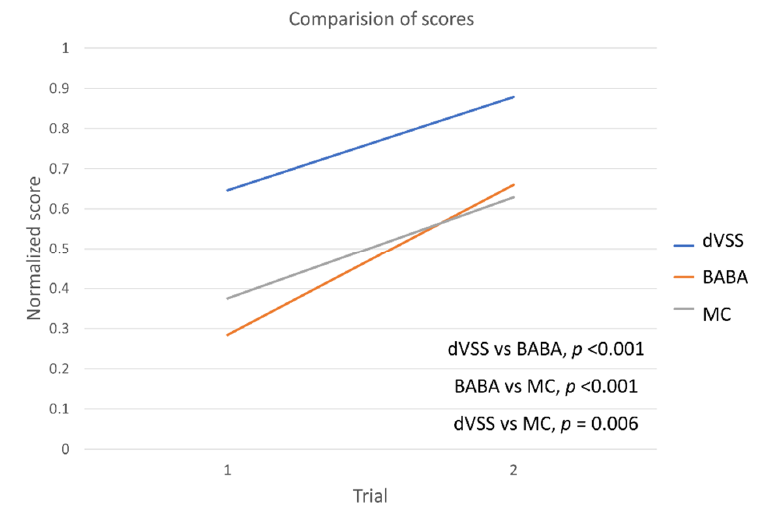
Figure 3. Correlations between the BABA, MC, and dVSS scores of the participants when they conducted two cycles of standardized BABA training model and dVSS tasks. Correlation analyses were performed using Pearson’s correlation